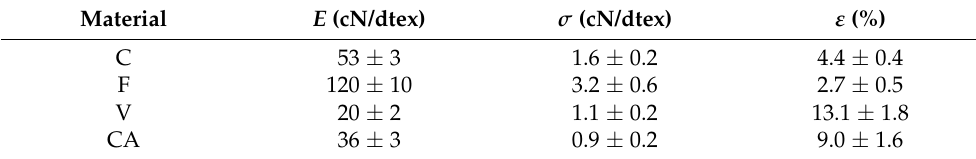
( c ) Figure 10. Evolutions as a function of the water mass gain of: ( a ) the normalized breaking stress ( 𝜎 (cid:3028) (cid:3298) /𝜎 (cid:2868).(cid:2872)(cid:2875) ) , ( b ) normalized deformation at break ( 𝜀 (cid:3028) (cid:3298) /𝜀 (cid:2868).(cid:2872)(cid:2875) ) and ( c ) normalized module ( 𝐸 (cid:3028) (cid:3298) /𝐸 (cid:2868).(cid:2872)(cid:2875) ) . 5. Conclusions In conclusion, this study has demonstrated that there are considerable differences in the sorption/desorption behavior between cellulosic derivatives. Hydrophilic behavior of cellulosic materials depends on their composition and their structural properties. More specifically, it depends on the amount of water sorption sites (hydroxyl groups) and the amorphous fraction, because crystalline part is considered permeable. To understand the sorption mechanisms from the thermodynamic and kinetic point of view, a Park and PEK model were used, respectively. The sorption and desorption isotherm curves for all fibers have a sigmoid or S-shape, which correspond to a type II classification of BET. The first part of the isotherm presents a concave form, which corresponds to the formation of the primary hydration sphere of the hydroxyl groups of cellulose. The linear evolution of the mass gain observed in the middle activity range was assigned to a random distribution of the water molecules. The convex part presented at high activity is attributed to the formation of water molecule clusters. V fibers exhibited the highest water sorption capacity allowed by the greatest